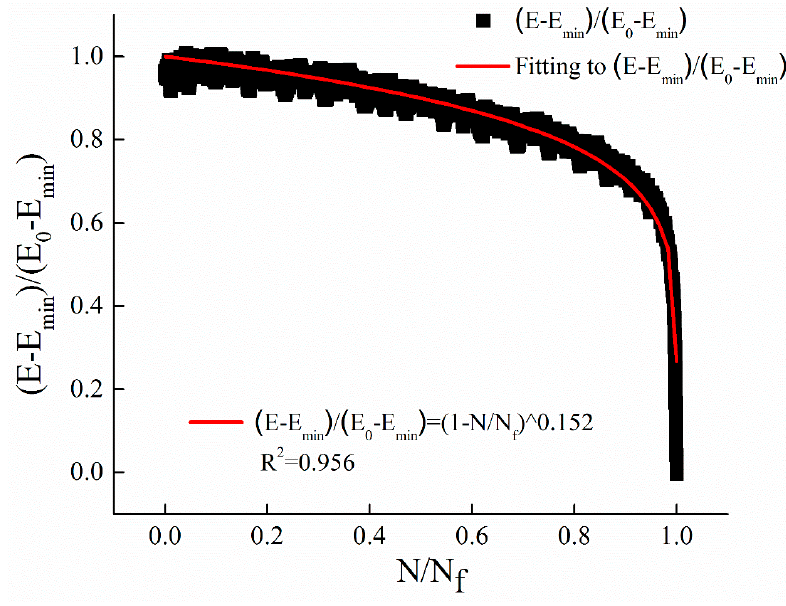
Figure 6. The regression results with stress levels of 0.25 MPa.